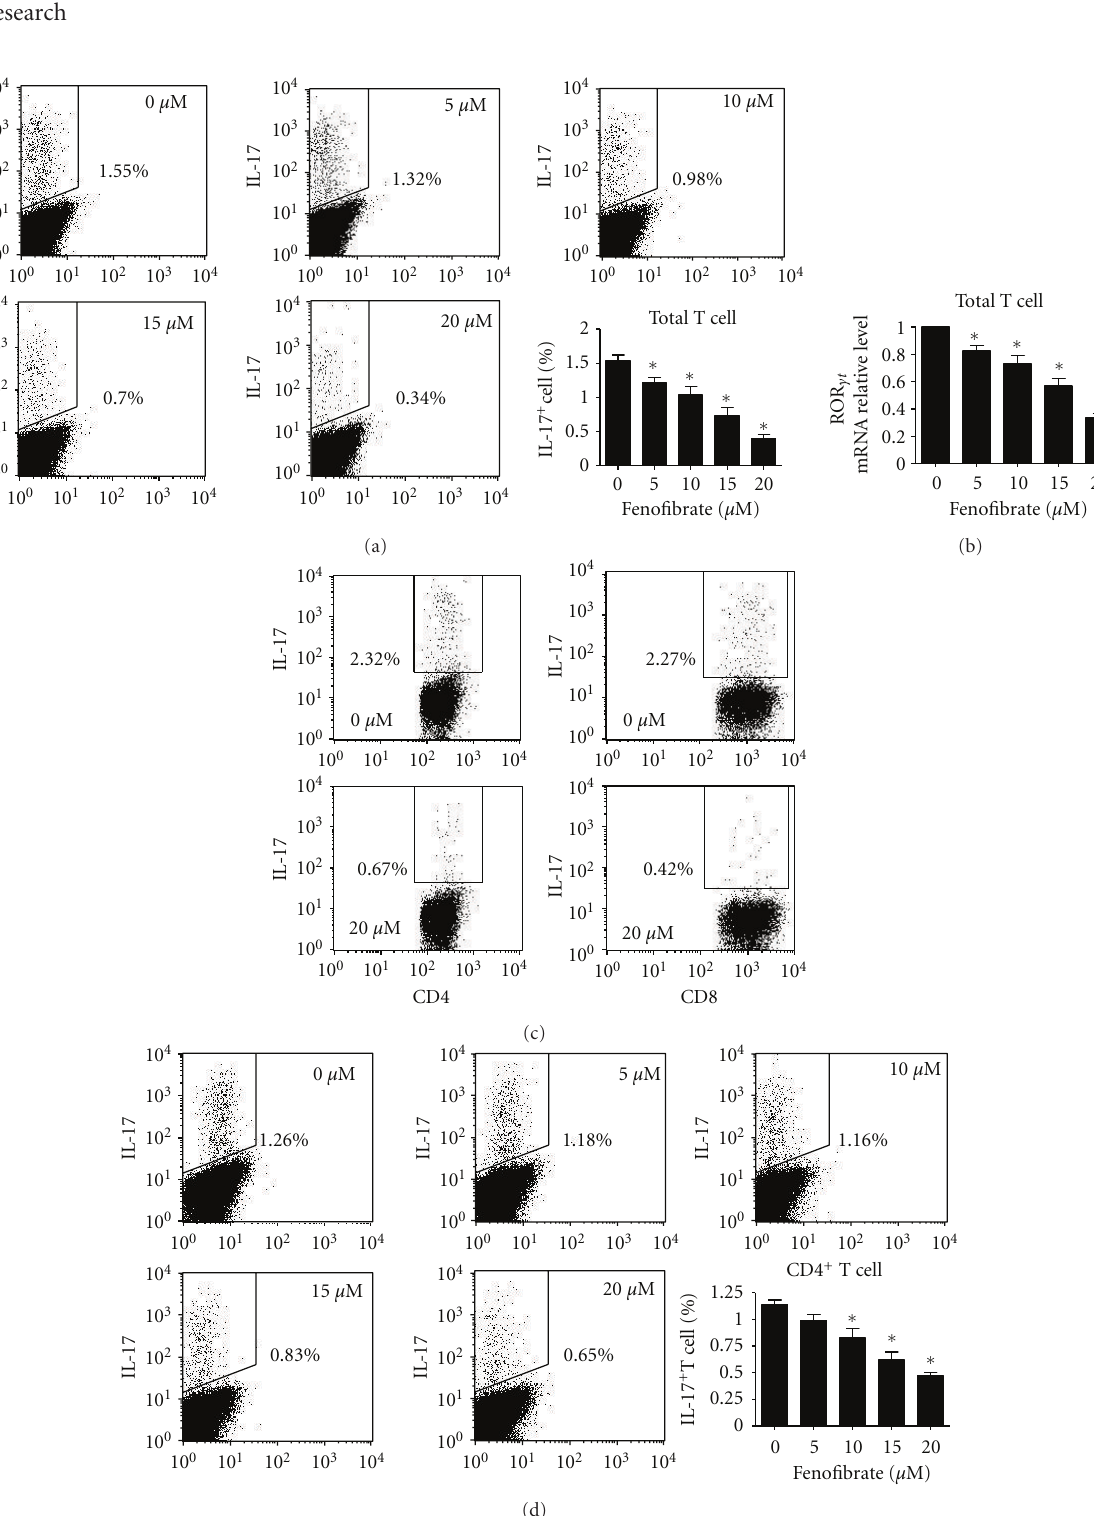
Figure 1: Fenofibrate inhibited the di ff erentiation of Th17 cells in vitro . (a) Total T cells were isolated from mouse spleens and induced di ff erentiation to IL-17 + cells with 10ng/mL TGF- β , 40 ng/mL IL-6, and fenofibrate final concentrations indicated. The percentage of IL- 17 + cells was analyzed with flow cytometry 4 days later. Total T cells were treated as above, the mRNA level of ROR γ t was analyzed with real-time PCR (b), and the percentages of IL-17 + cells in CD4 + and CD8 + T cell subgroups were analyzed separately according to di ff erent staining patterns with flow cytometry (c). (d) CD4 + T cells were isolated from mouse spleens and induced to di ff erentiate into Th17 cells with 10ng/mL TGF- β , 40ng/mL IL-6, and fenofibrate final concentrations indicated. The percentage of Th17 cells was analyzed with flow cytometry 4 days later. In (a and d), numbers at the corner indicate the final concentration of fenofibrate, and the percentages of IL-17 + cells were shown adjacent to the outlined areas, n = 3 ∼ 4, ∗ P < 0 . 05 versus 0 μ M group. In (b), n = 3, ∗ P < 0 . 05 versus 0 μ M group. In (c), data represent one of three independent